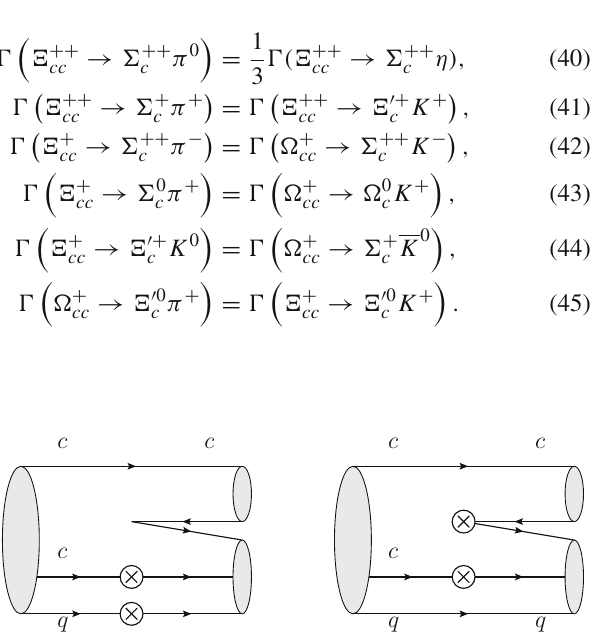
Table 7 Doubly charmed baryons decays into a light baryon in the octet and a charmed meson